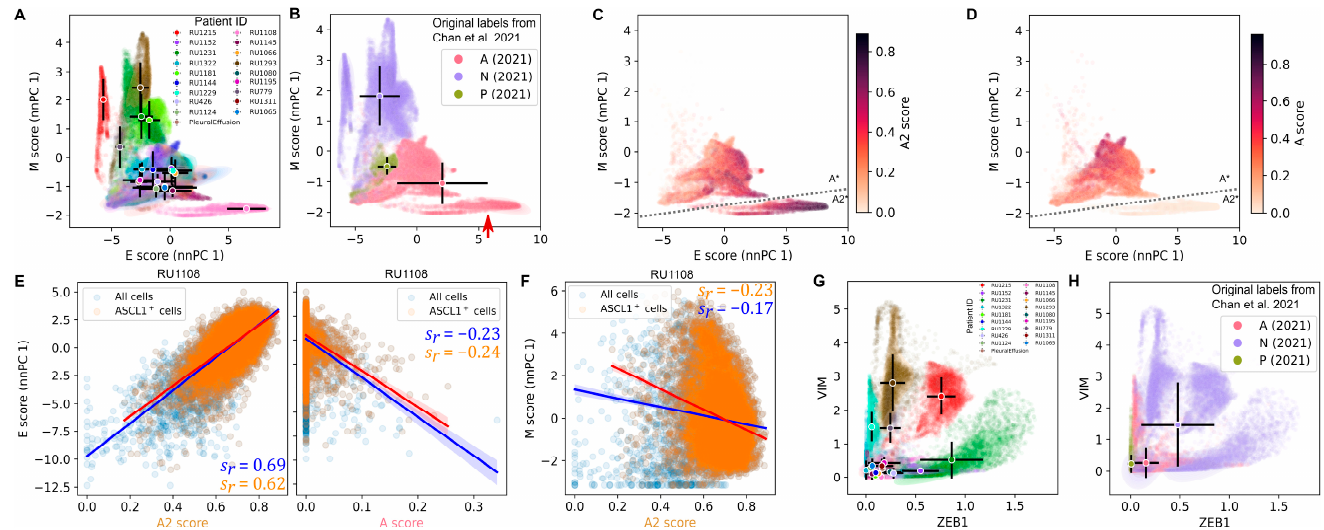
Figure 3. Detection of epithelial- and mesenchymal-like SCLC subtypes in human tumor cells. ( A ) Scatter plot shows nnPCA-based E and M scores for 54,523 SCLC cells [35]. Color code represents each of the 19 patients. Circles and black bars show means and standard deviations of cell scores for each patient. ( B ) Same data as in A with SCLC subtype labels obtained from Chan et al. [35]. Circles and black bars show means and standard deviations of scores across the previously determined SCLC subtypes. ( C , D ) Scatter plots show A2 and A subtype scores in the previously determined SCLC-A subtype cells from the data in B. ( E , F ) Transcriptome data of 11,056 SCLC cells from tumor RU1108 of the Chan et al. study [35] were projected onto indicated score axes. Linear regression lines and confidence intervals were obtained for all cells and ASCL1 + cells. s r is Spearman correlation coefficient. ( G ) Normalized expression of ZEB1 and VIM in the same dataset as in A. Color code represents each of the 19 patients as in A. ( H ) The same data as in G but color labels are defined by SCLC subtype shown in B.